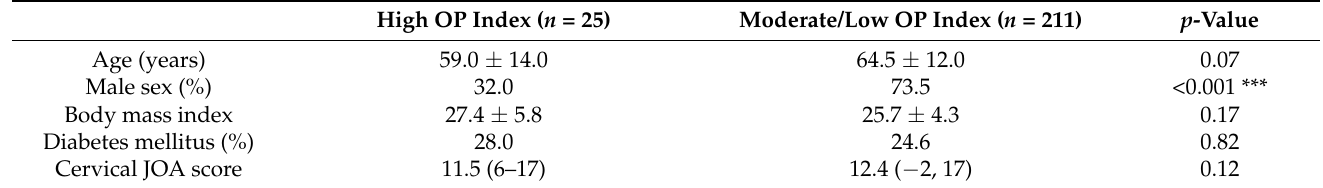
Table 1. Demographic and clinical characteristics of patients with ossification of the posterior longitudinal ligament according to whether they had a high or moderate/low OP